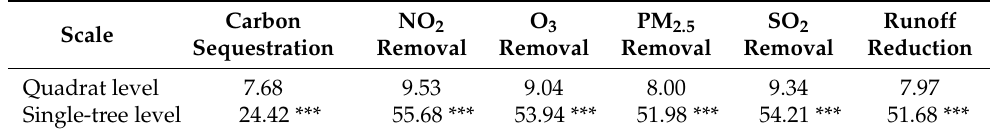
Table 3. Chi-square statistics of comparison of ecosystem services across land use by Kruskal–Wallis rank sum test (the level of significance is denoted by asterisks: ***, p <